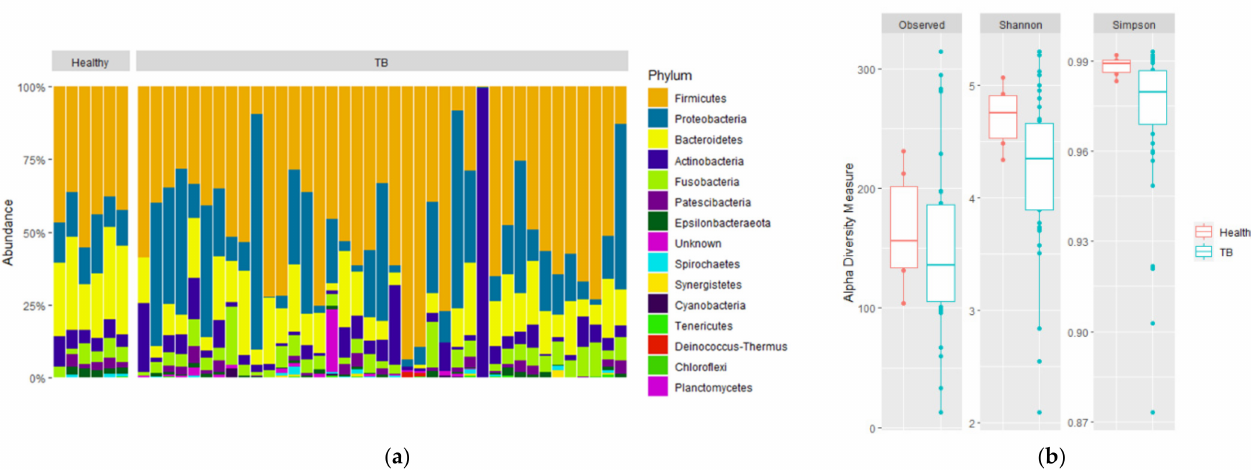
Figure 1. Composition and alpha diversity of sputum microbiota of healthy volunteers and TB patients. 16S rDNA from sputum samples were sequenced, and relative abundances for phyla are shown for ( a ) individual sample relative abundances of phyla by group: healthy volunteers, drug-sensitive TB, and drug-resistant TB. ( b ) Comparison of alpha diversity based on the number of observed species, Shannon diversity, and Simpson diversity of HVs (red) and TB patients (green). Statistical significance between groups is indicated by ( p < 0.05; Wilcoxon test).